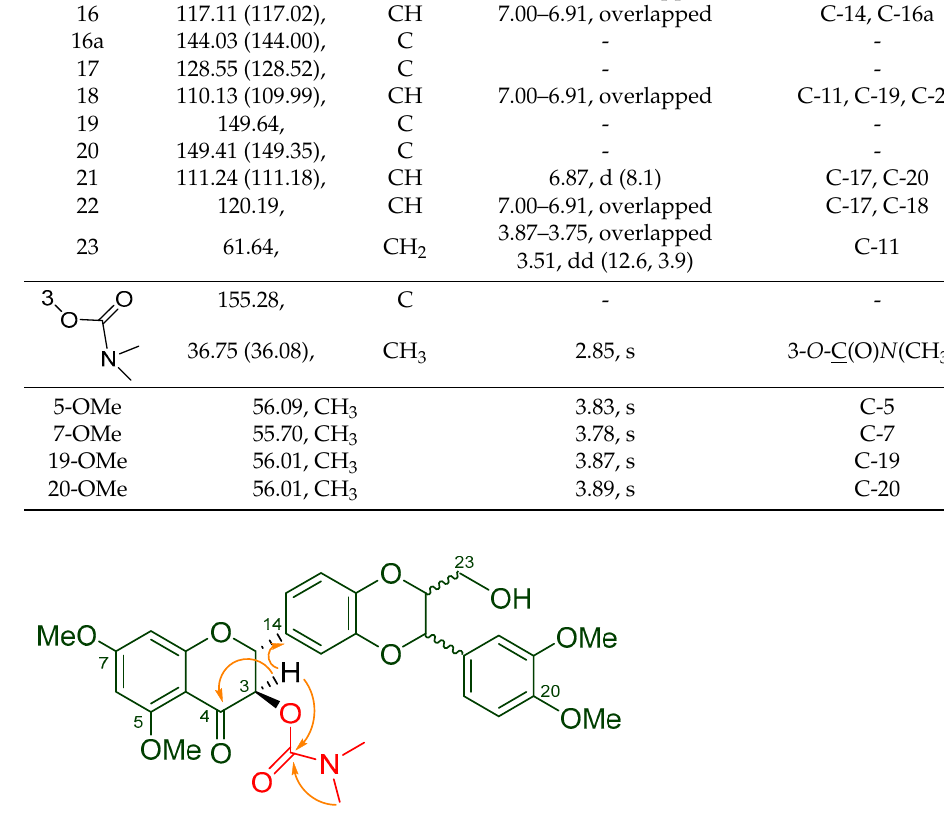
Figure 2. Key HMBC correlations (from H to C) in 5 .